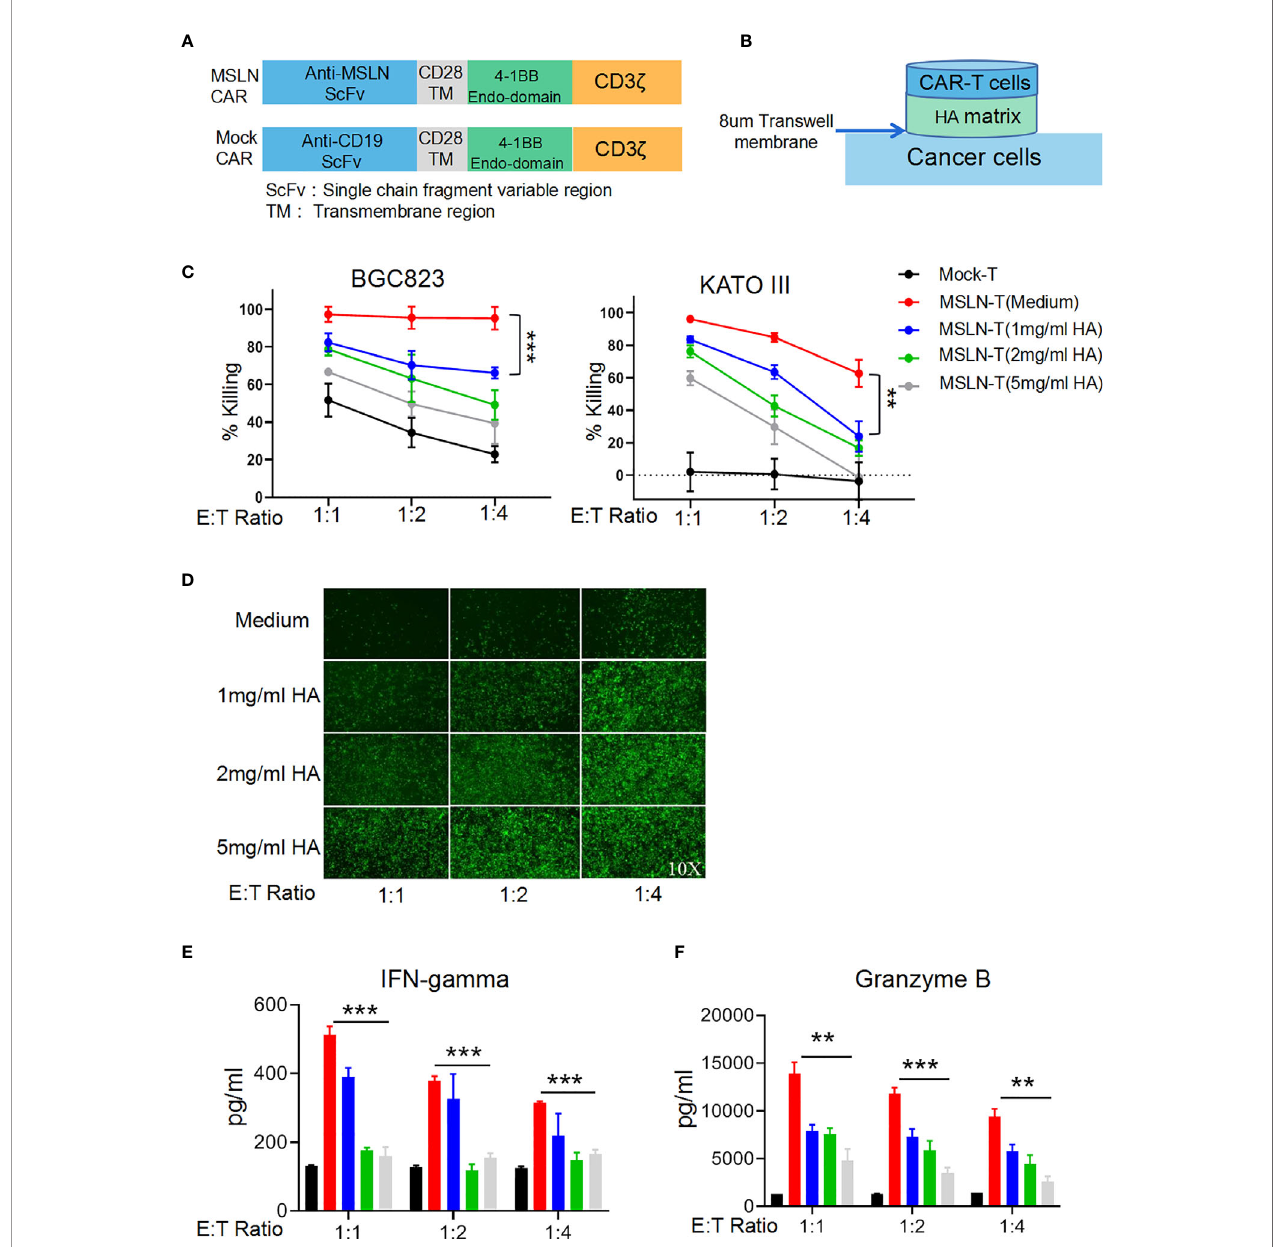
FIGURE 2 | HA restricts T cell mobility and inhibits the antitumor effect of CAR-T cells. (A) Schematic diagram of the structures of CAR gene expression cassettes. (B) Schematic diagram of the Transwell tumor killing coculture system. (C) Results of killing assays performed with anti-MSLN CAR-T cells targeting the gastric cancer cell lines BGC823GL and KATOIIIGL in the Transwell coculture system; error bars denote the S. D, and the results were compared with two-way ANOVA. **P<0.01. (D) GFP fl uorescence images of viable BGC823GL cells at the endpoint of the killing assay at each E:T ratio. (E) Concentrations of IFN- g and (F) Granzyme B in the supernatant of Transwell chambers at each E:T ratio determined by ELISA; error bars denote the S. D, and the results were compared with an unpaired t test. **P<0.01; ( Figure 4D ). Immunohistochemical staining for CD3